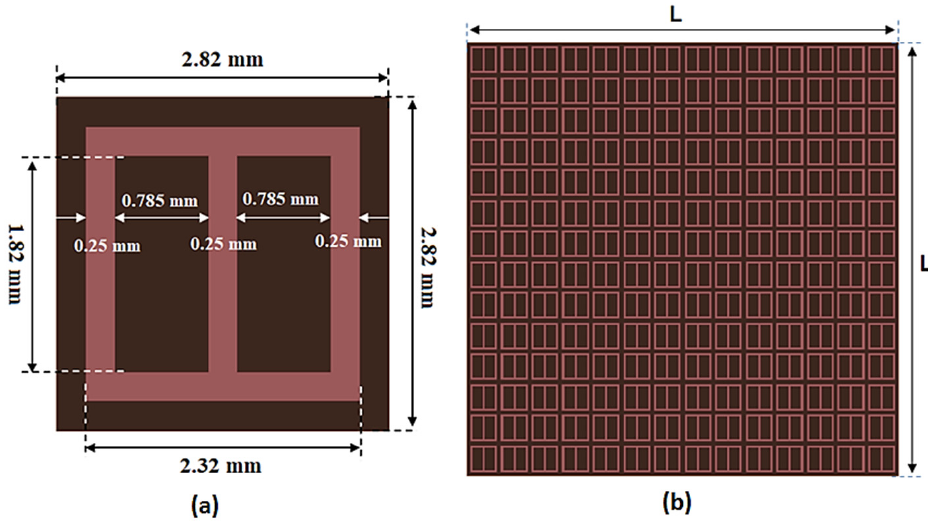
Figure 15. The FSS structures ( a ) Unit cell and ( b ) the suggested FSS array cells.